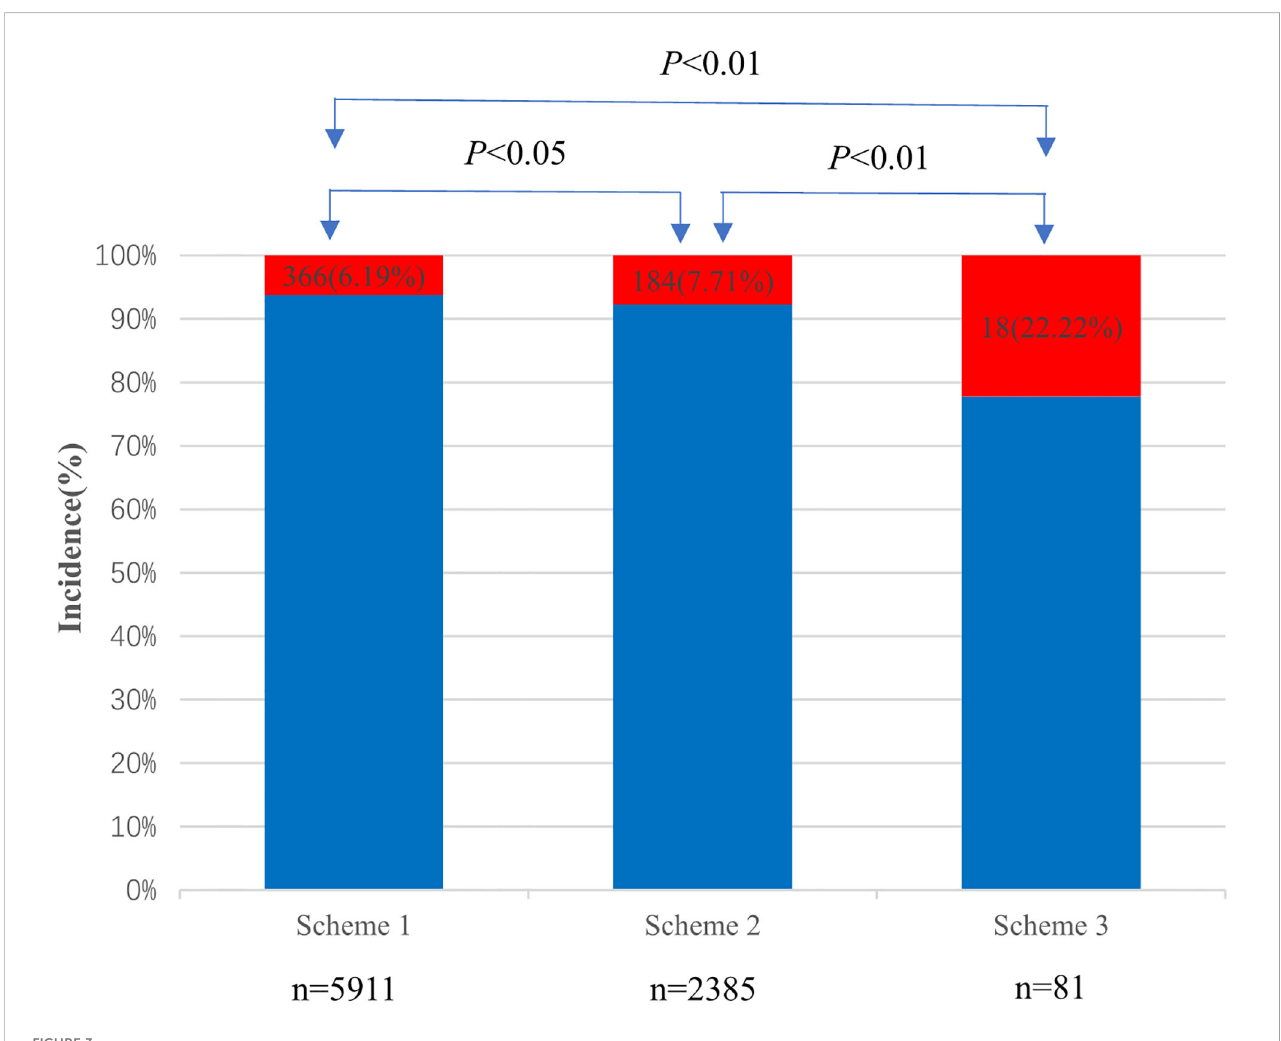
FIGURE 3 Incidence of PC-AKI in three